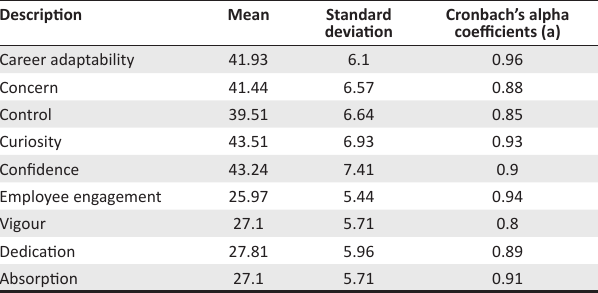
TABLE 2: Descriptive statistics: Career Adapt-Abilities Scale and Utrecht Work Engagement Scale.